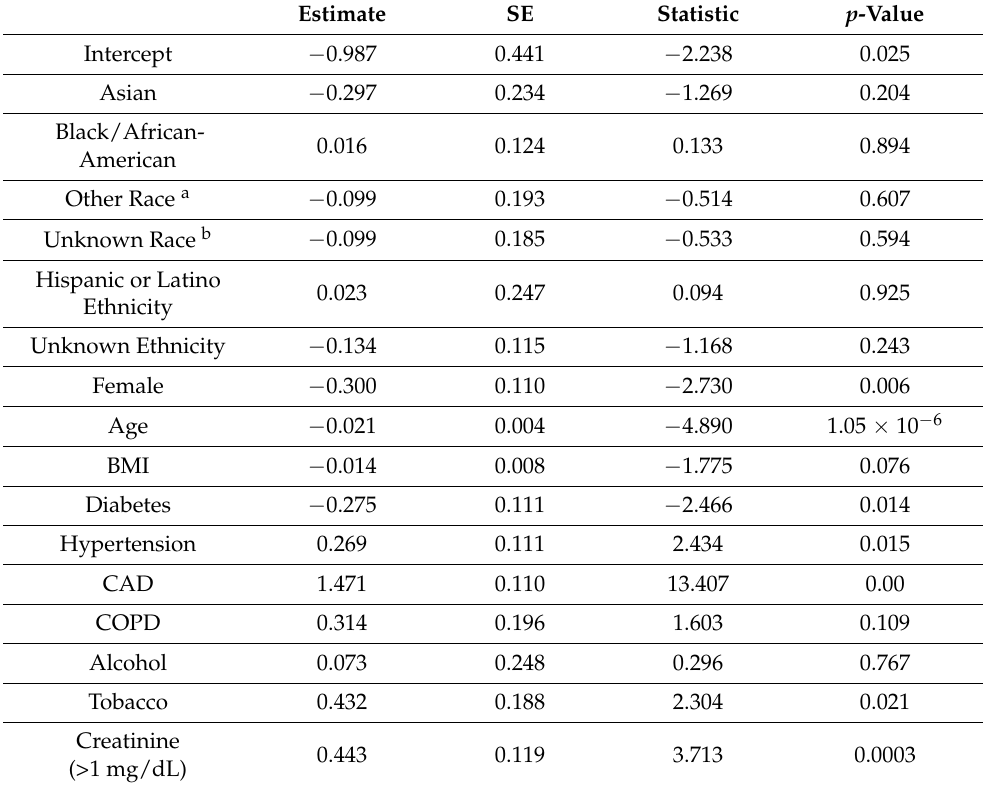
Figure 2. Race-only model for clopidogrel adverse events and bleeding events. Shown is the probability of experiencing any adverse outcome ( A ) or bleeding events ( B ) while taking clopidogrel based on race only. All comparisons used the White group as the reference. Table 4. Logistic regression model for adverse drug reactions associated with clopidogrel use relative to White/European-American patients #